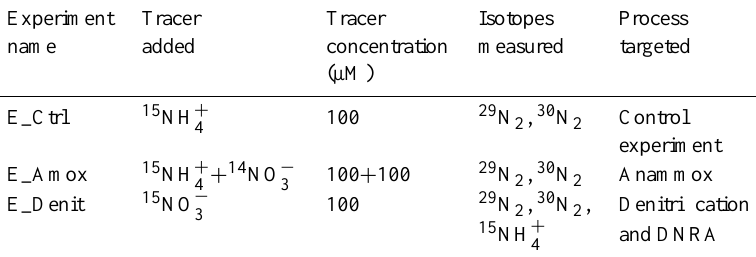
Table 2. Slurry incubation approaches performed in this